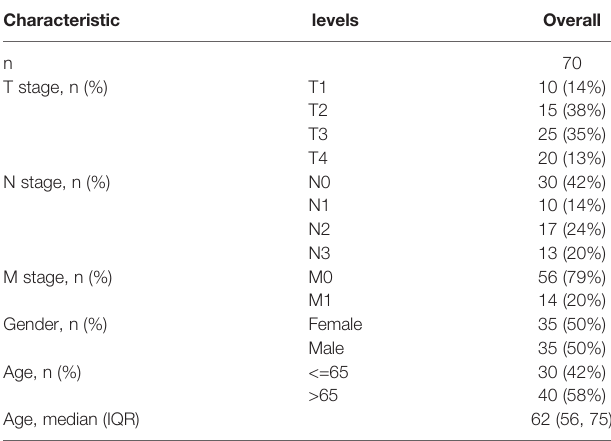
TABLE 2 | Clinical characteristics of the GC patients used in the validation